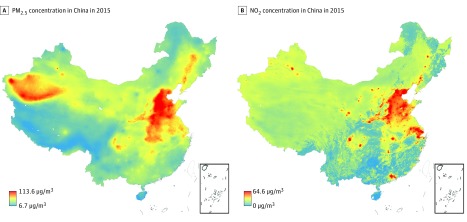
Spatial Distribution of Estimated Annual Pollution Concentrations in 2015 in ChinaA, Concentration of particulate matter with aerodynamic diameter less than 2.5 μm (PM2.5) per 1 × 1 km2. B, Concentration of nitrogen dioxide (NO2) per 1 × 1 km2.